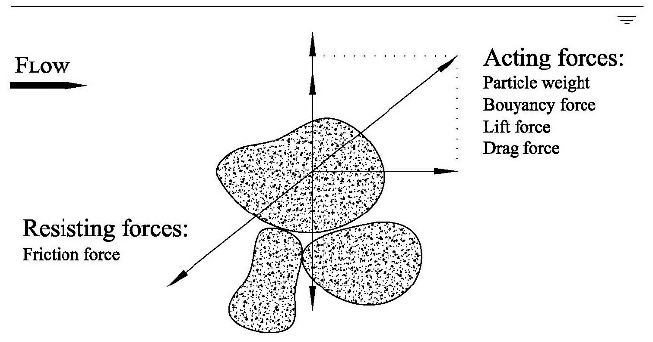
Figure 1. Force balance for particles under the action of flowing water.